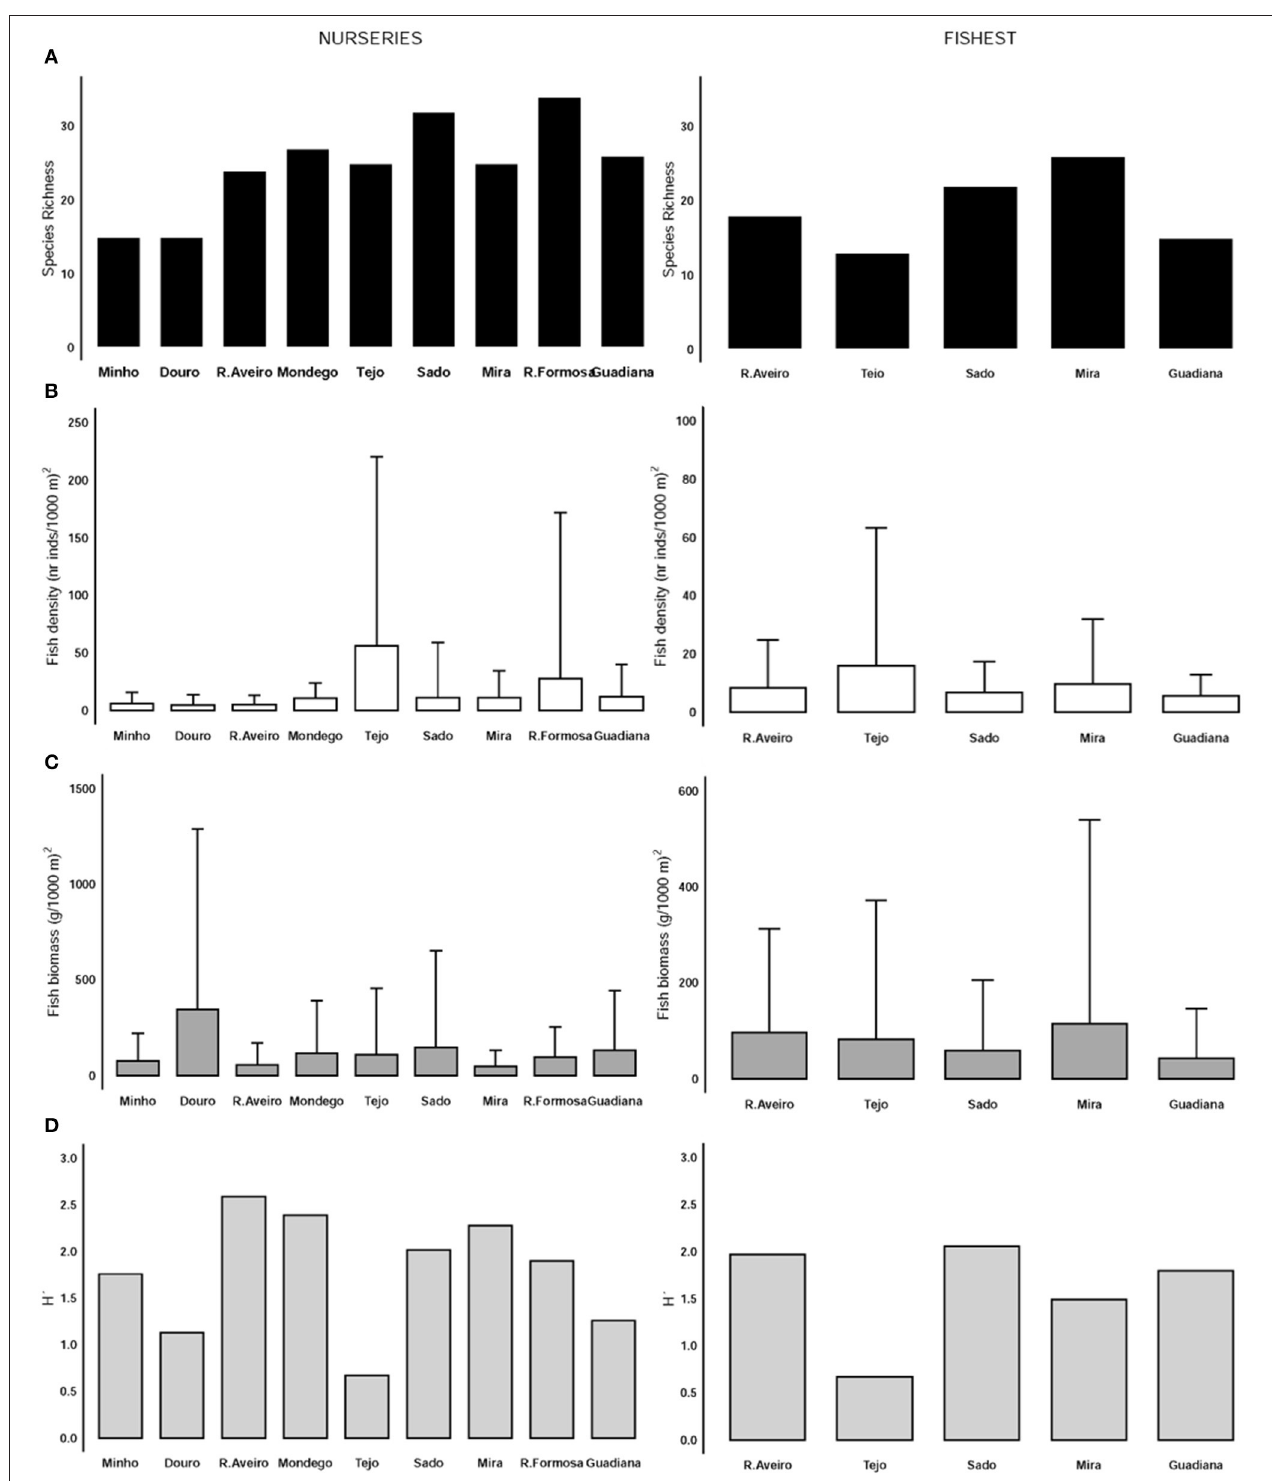
FIGURE 2 | Variation of the Species Richness (A) , Mean values of fish density (nr inds.1,000 m − 2 ) and standard deviation (B) , Mean values of fish biomass (g.1,000 m − 2 ) and standard deviation (C) and the Shannon-Wiener diversity index (D) between estuaries, for the NURSERIES and the FISHEST projects.